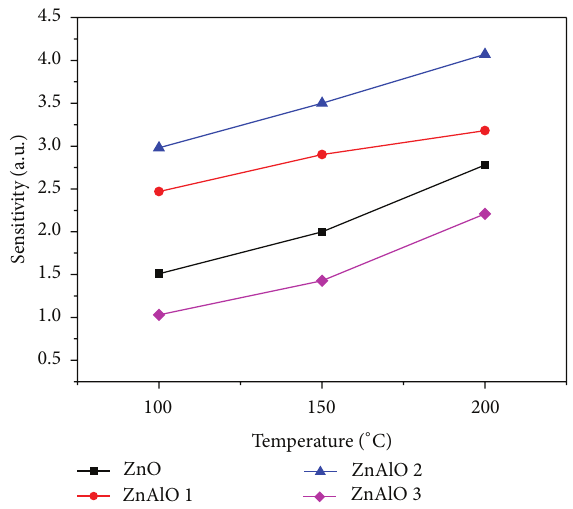
Figure 6: The operating temperature influence on the sensitivity of zinc aluminum oxide gas sensor upon exposure to oxygen 20 vol.%.